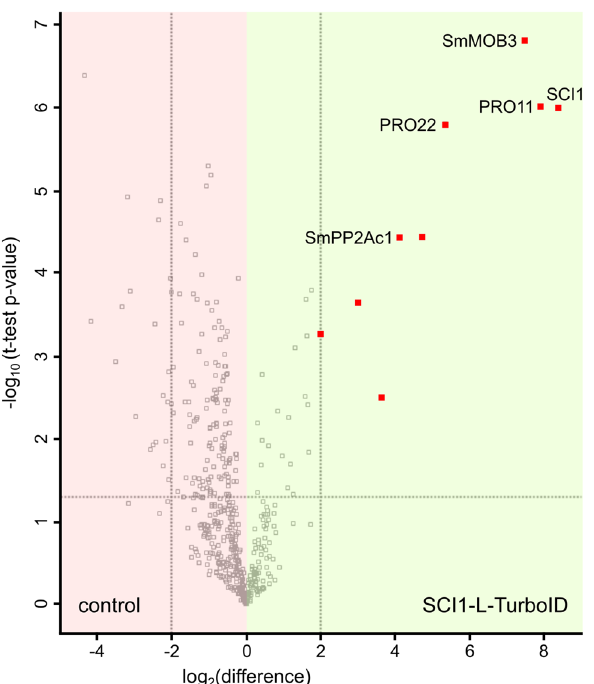
Figure 5. Volcano plot of proteins identified in the SCI1-BioID experiment. The volcano plot depicts the differences of log 2 transformed LFQ intensities between Δsci1::p5’-sci1-L-TurboID ect and the control (wt::pc- L-TurboID ect diluted 1:6 with wild-type crude protein extract) on the x-axis. The −log 10 (p-value) is plotted on the y-axis. The gray dotted threshold lines indicate a p-value of 0.05 (horizontal) and a log 2 (difference) of −2 or + 2 (vertical). Missing values were imputed in four repetitions. Proteins that were significantly enriched (log 2 (difference) ≥ 2) in the SCI1-L-TurboID strain in all four imputations are marked with a red